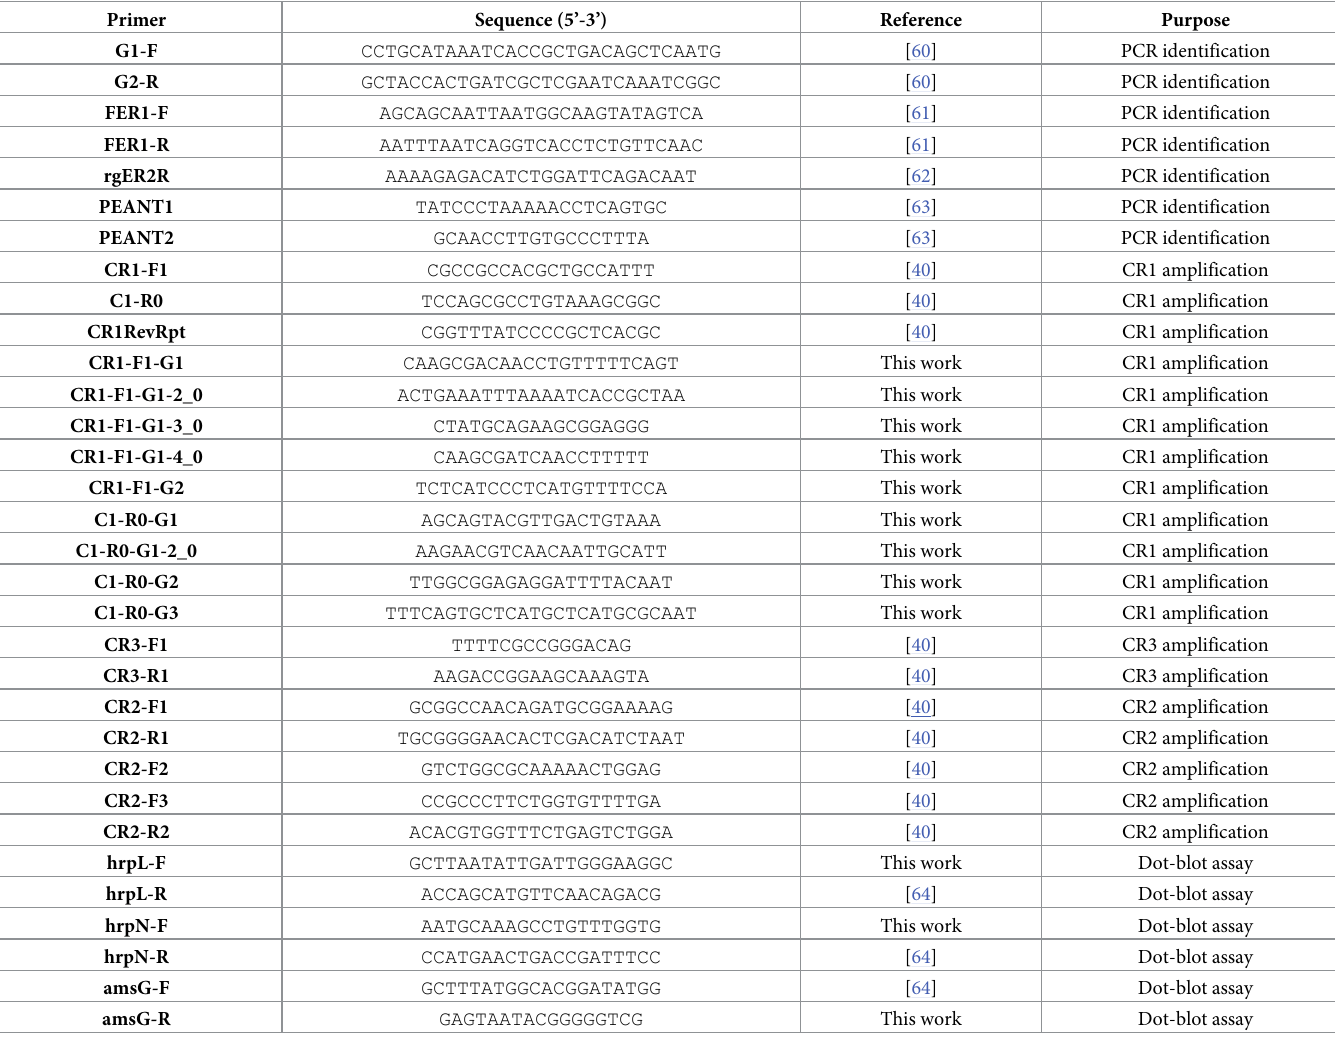
Table 2. List of primers used in this